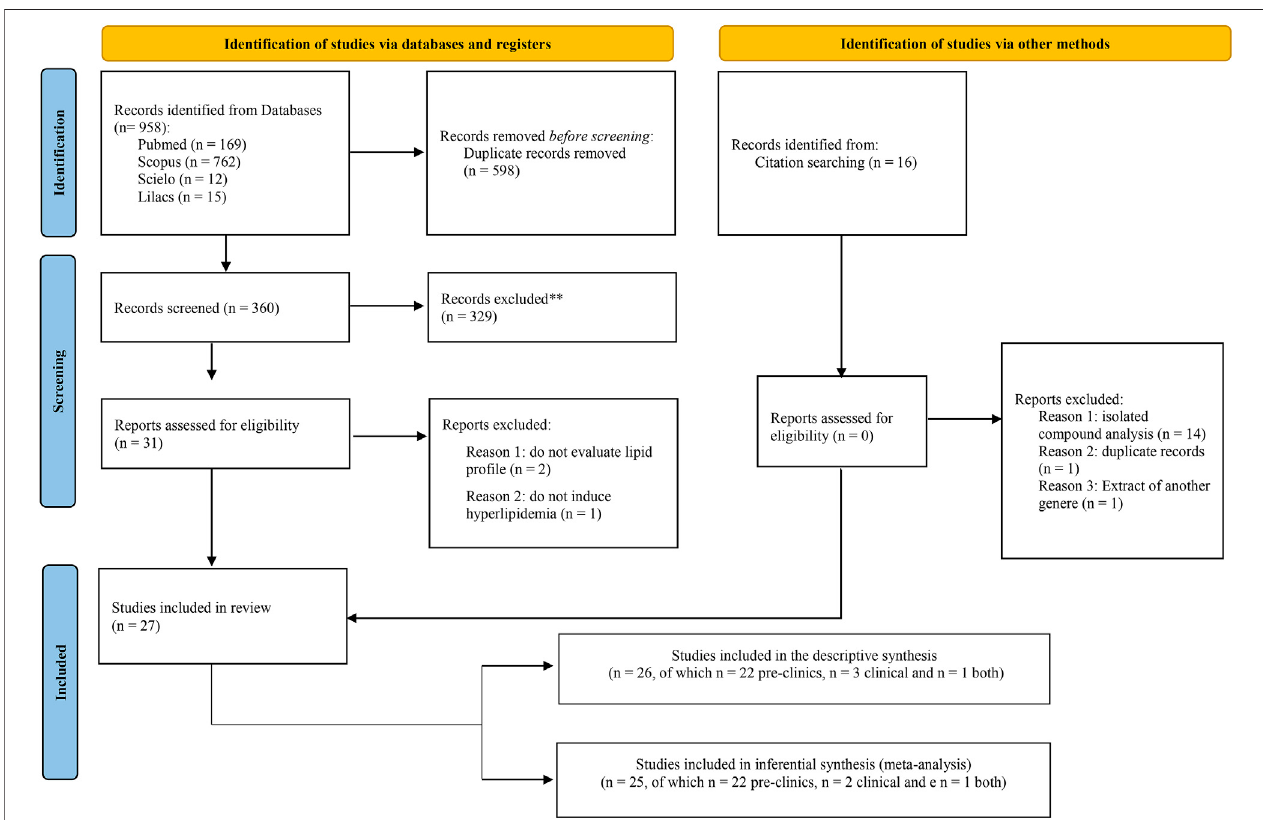
FIGURE 1 | Flowchart of the studies included in the qualitative and quantitative synthesis.